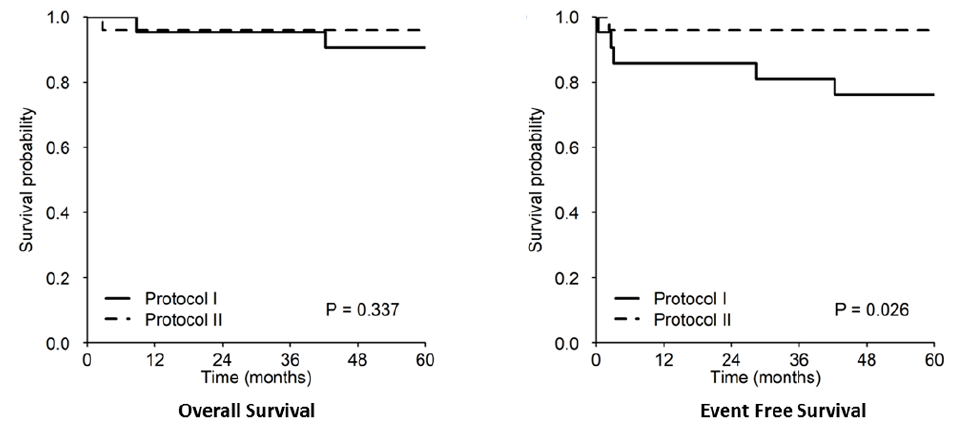
Figure 2. The 5-year OS/EFS rates in protocols I and II.